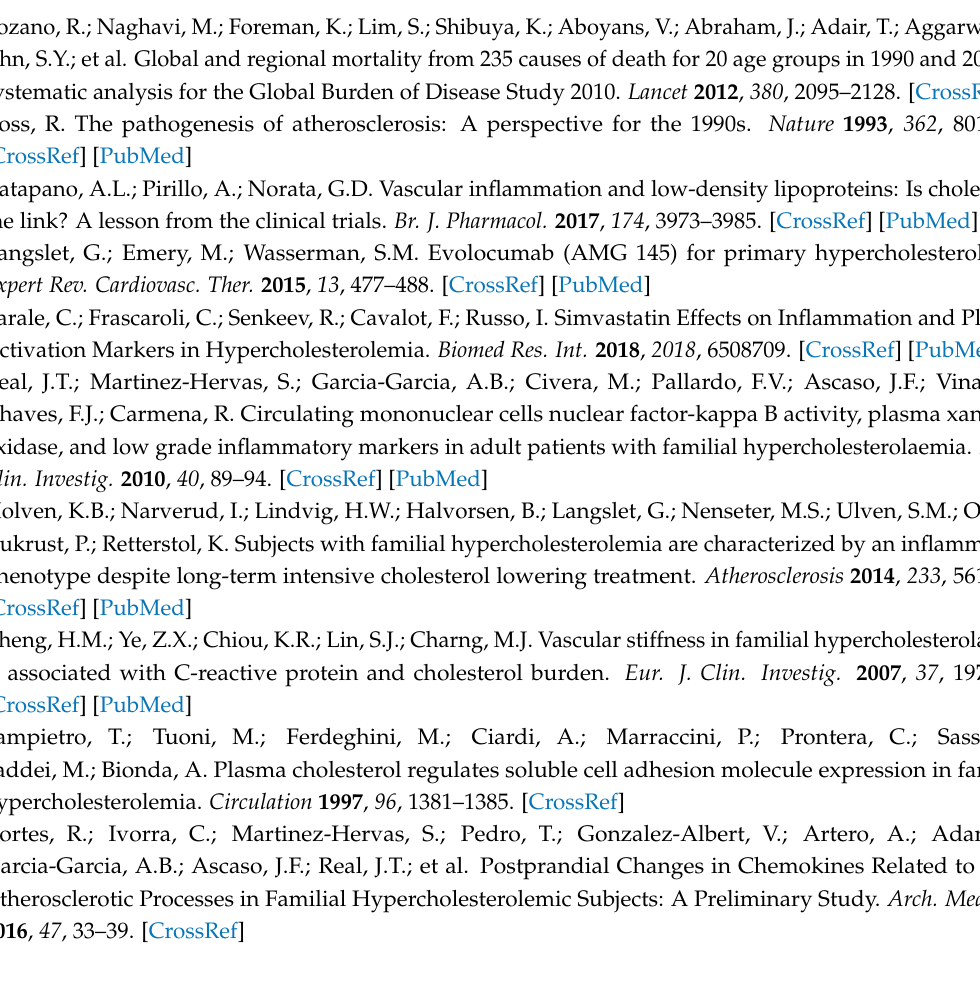
Figure S1. Gating strategy for human platelets in whole blood according to morphological properties and CD41 detection by flow cytometry, Figure S2. Gating strategy for human neutrophils in whole blood according to morphological properties and CD16 expression by flow cytometry, Figure S3. Gating strategy for human monocyte detection in whole blood by flow cytometry, Figure S4. Gating strategy for human T lymphocyte detection in whole blood by flow cytometry, Figure S5. Gating strategy for human T helper lymphocyte detection in whole blood by flow cytometry, Figure S6. Gating strategy for human regulatory T lymphocyte (Treg) detection in whole blood by flow cytometry, Figure S7. Positive correlation between the percentage of nonclassical/Mon 3 monocytes and the circulating levels of ApoB (A), LDL (B) and TC (C). Table S1. Differential markers of monocyte subpopulations, Table S2. Differential markers for detection of Th lymphocyte